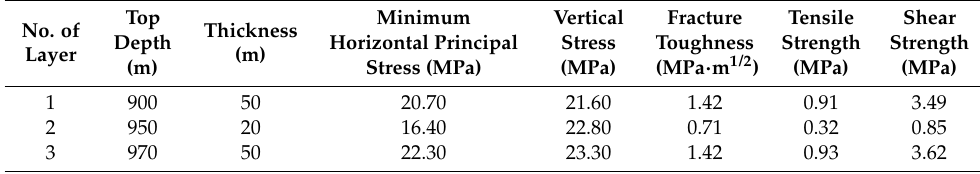
Figure 5. The changes of fracture height with injection pressure at the perforation.